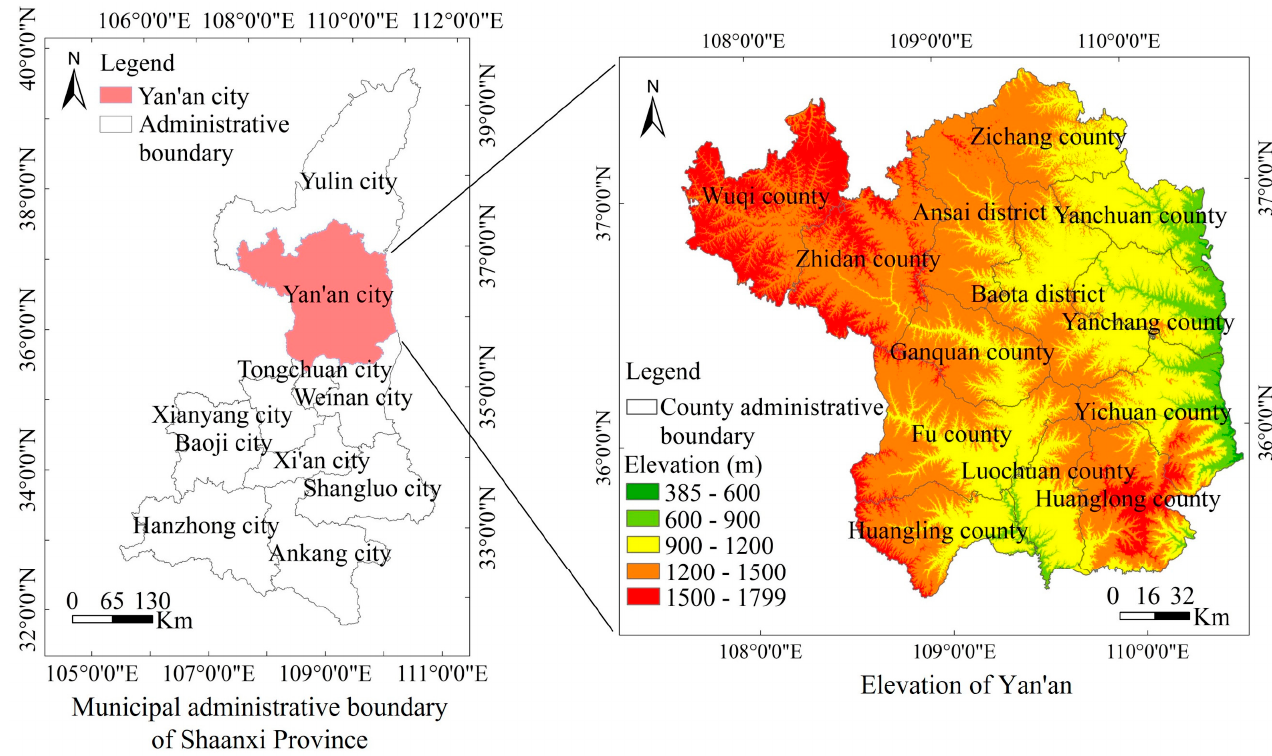
Figure 1. Location of the study region. Including the municipal administrative boundary of Shaanxi Province ( left ), and the elevation of Yan’an ( right ).